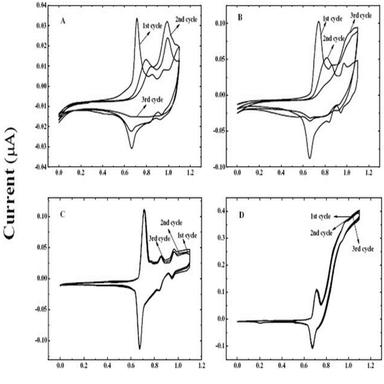
Cyclic voltammograms performed on LiCoO2 using a saturated calomel electrode in a 1 M Li2SO4 solution. These experiments were conducted at a scan rate of 10 mV s − 1 across various pH values, within a potential window of 0–1.1 V: (A) pH 7, (B) pH 9, (C) pH 11, and (D) pH 13 . Reproduced with permission from IOP Science.